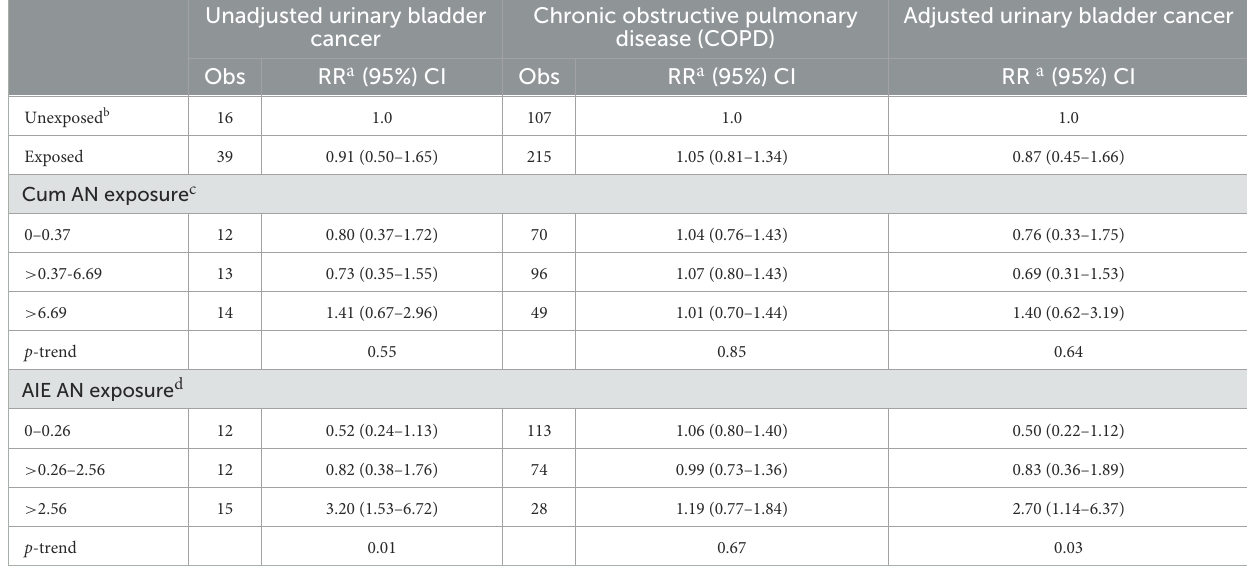
TABLE 7 UPitt urinary bladder cancer relative risks (RR) in relation to AN exposure adjusted for potential confounding by smoking using the Richardson method, full cohort, 1942–2011. Unadjusted urinary bladder Chronic obstructive pulmonary Adjusted urinary bladder cancer disease (COPD)